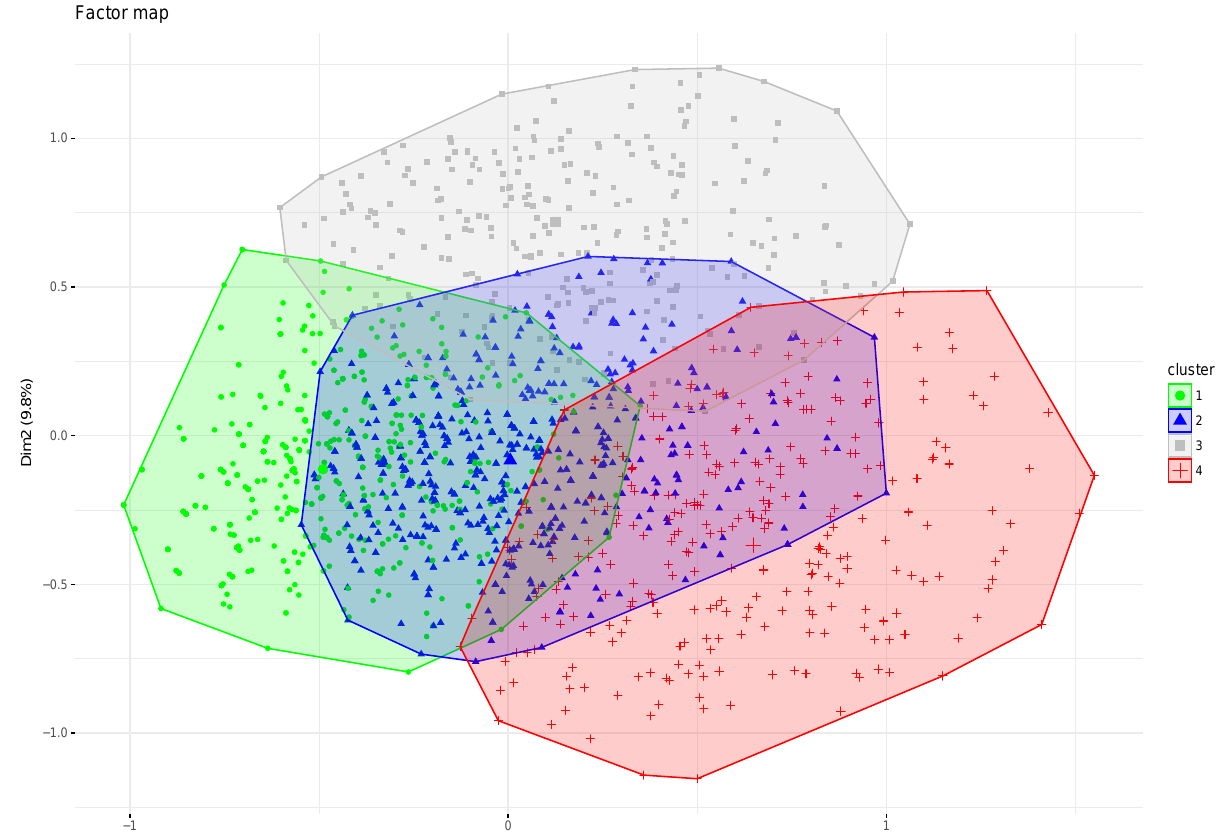
Figure 2. Cluster solution. Notes: Cluster 1 = ‘foreign working-class,’ cluster 2 = ‘foreign middle-class,’ cluster 3 = ‘adapted German migrants,’ cluster 4 = ‘young highly educated urbans.’ Source: SOEP (2019, survey year 2015). German citizens are a minority among them (6%).